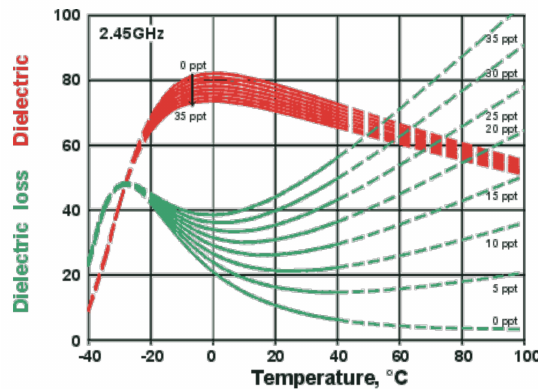
Figure 1. The e ff ect of salt concentration on dielectric constant and dielectric loss under microwave irradiation